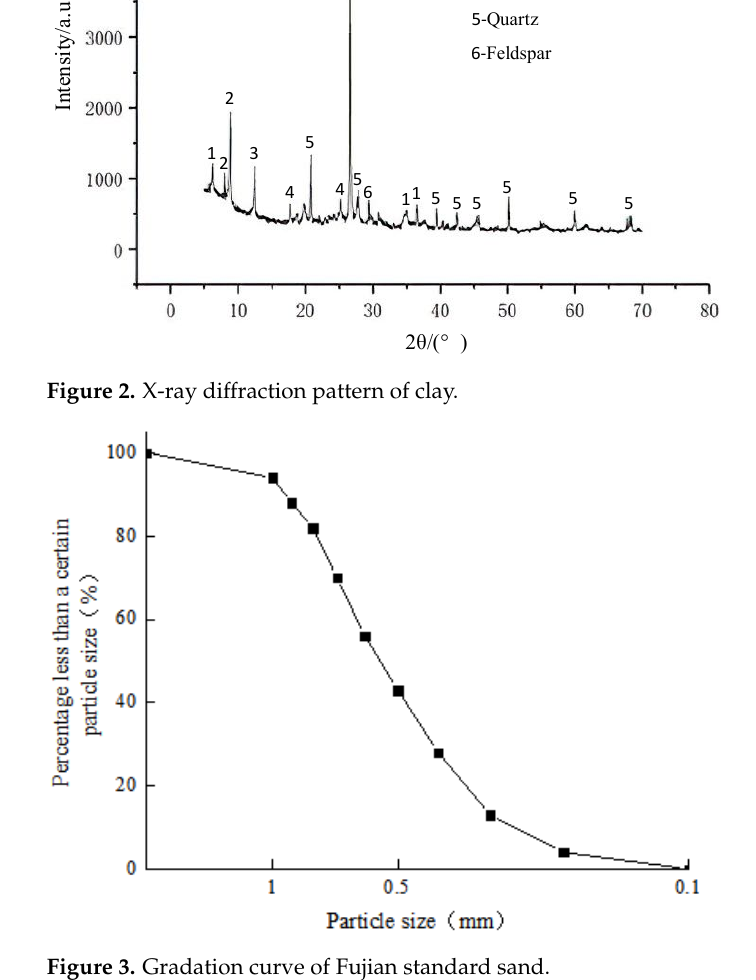
Figure 3. Gradation curve of Fujian standard sand.